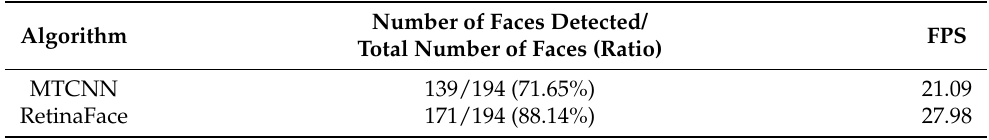
Table 7. RetinaFace and MTCNN performance comparison.